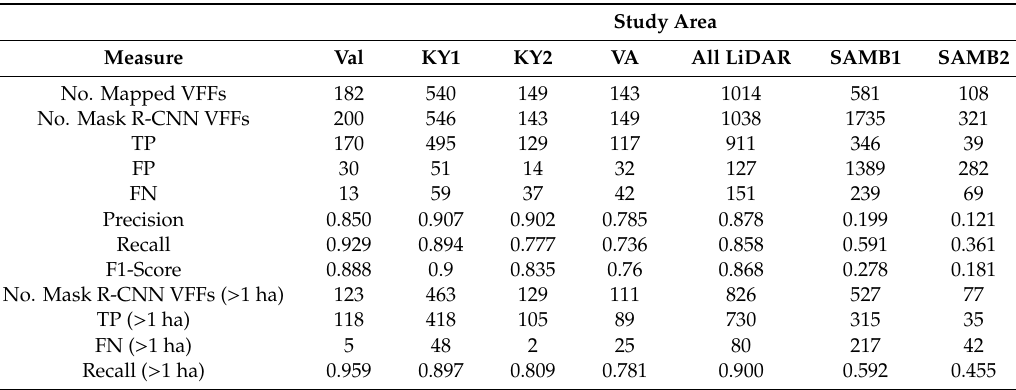
Figure 7. ( a ) through ( e ) Example of false positives. Table 4. Validation based on manual comparison of numbers of